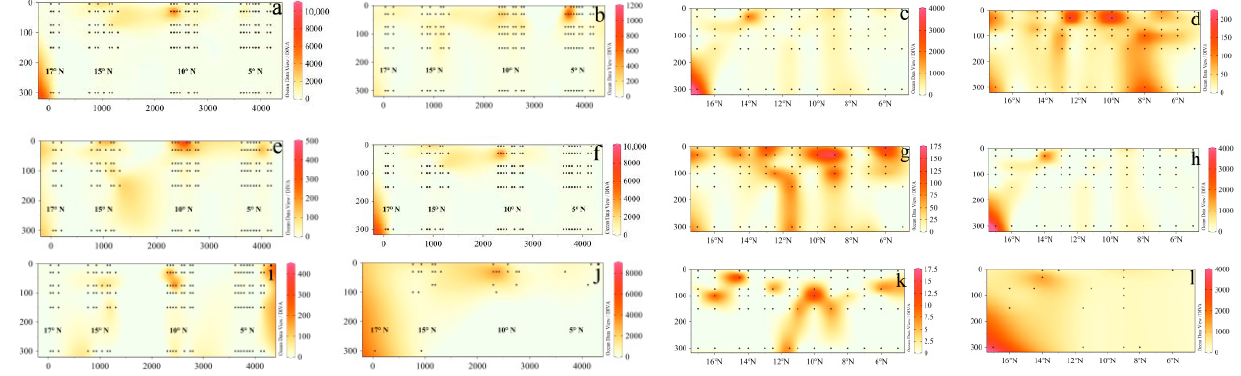
Figure 4. Horizontal distribution (weight-average) of the dominant phytoplankton species in the BOB (cells L − 1 ). (a) Trichodesmium spp.; (b) Synedra spp.; (c) Prorocentrum lenticulatum; ( d) Coscinodis- cus granii; ( e) Eunotogramma debile; ( f) Dictyocha fibula; (g) Thalassionema frauenfeldii; (h) Tripos furca; (i) Planktoniella formosa; (j) Coscinodiscus subtilis.